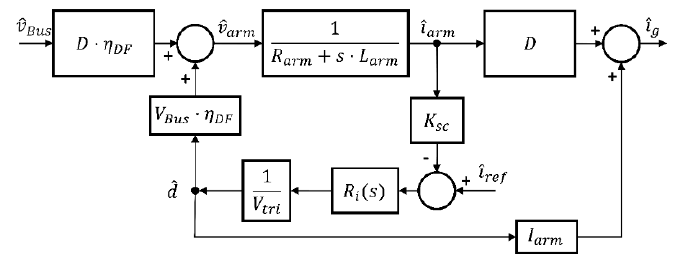
Figure 18. Block diagram of the motor drive-electric motor-vehicle system, including the inner control loop.